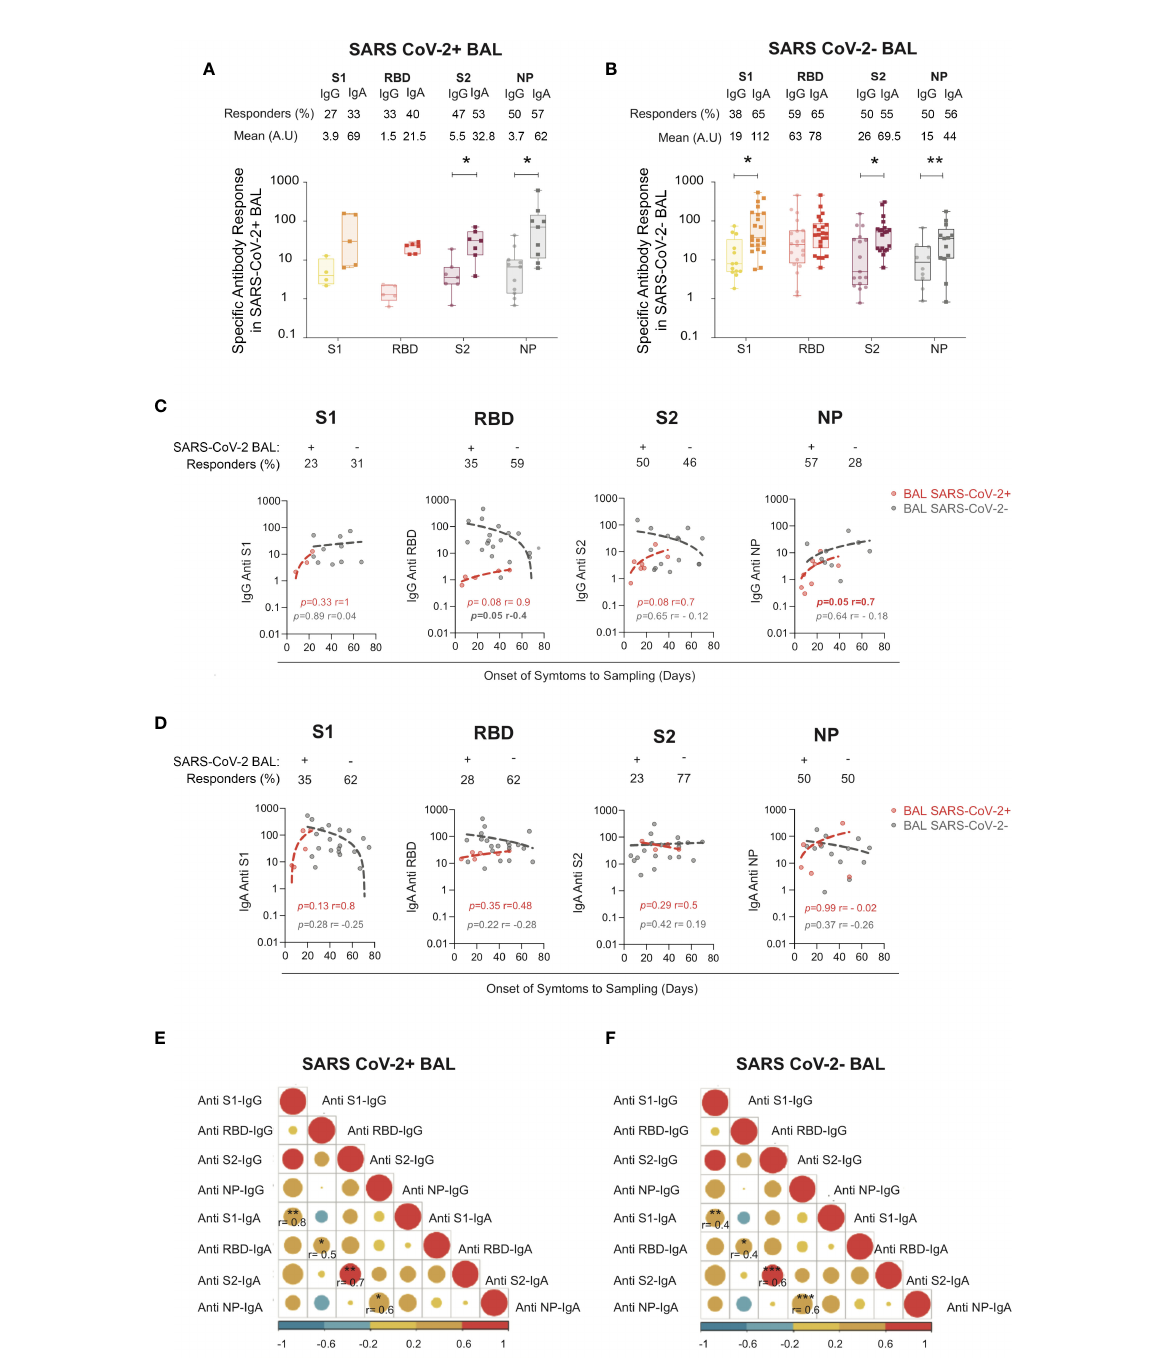
FIGURE 2 S1-, RBD-, S2-, and NP-speci fi c IgG and IgA in SARS CoV-2+ vs SARS-CoV-2 − BAL. (A) S1-, S2-, RBD-, and NP-speci fi c IgG and IgA responses in SARS-CoV-2+ BAL (B) S1-, S2-, RBD-, and NP-speci fi c IgG and IgA responses in SARS-CoV-2 − BAL. (A, B) Proportion of speci fi c IgG or IgA over total IgG or IgA measured by ELISA. Speci fi c (OD450)/total IgA or G ( m g/ml) are shown. p -Values were calculated by using Mann – Whitney test: *, p < 0.05; **, p < 0.01; ***, p < 0.005. (C) Correlations between speci fi c S1-, RBD-, S2-, and NP-speci fi c IgG antibodies in SARS-CoV-2+ BAL (red dots) and SARS-CoV-2 − BAL (gray dots) and onset of symptom to sampling date (days). (D) Correlations between S1-, RBD-, S2-, and NP-speci fi c IgA antibodies SARS-CoV-2+ BAL (red dots) and SARS-CoV-2 − BAL (gray dots) and onset of symptom to sampling date (days). (E) Correlation between speci fi c S1, RBD, S2, and NP IgA and IgG antibodies in SARS-CoV-2+ BAL individuals. (F) Correlation between S1-, RBD-, S2-, and NP-speci fi c IgA and IgG in SARS-CoV-2 − BAL individuals. All correlations were calculated using Spearman ’ s test. RBD, receptor-binding domain; NP, nucleocapsid